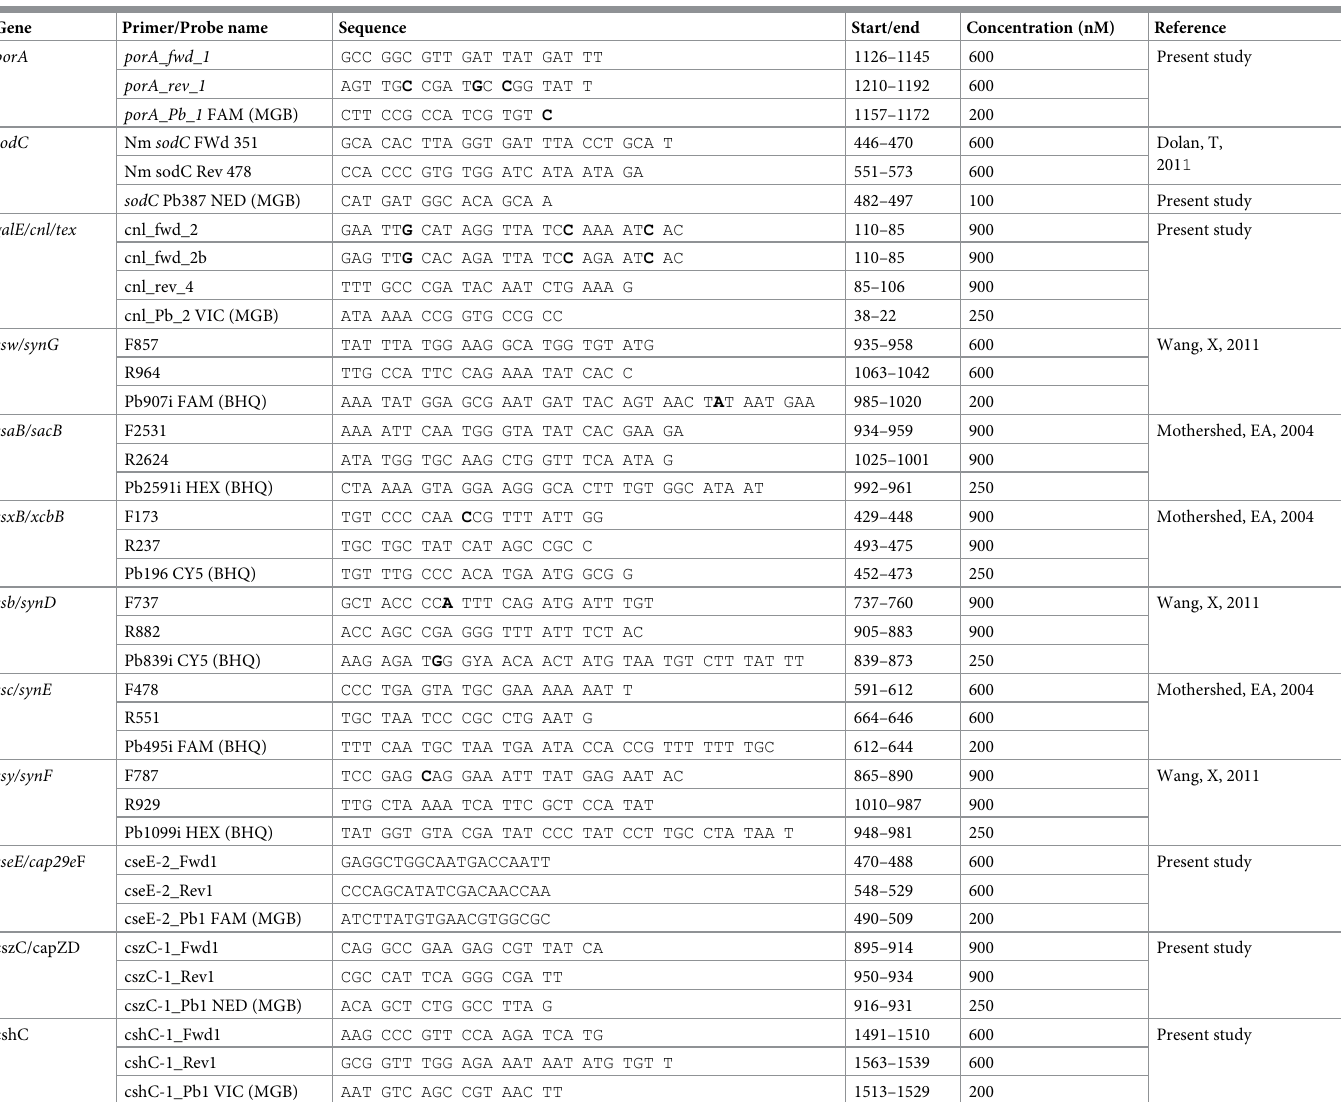
Table 2. Primer and probe sequences for